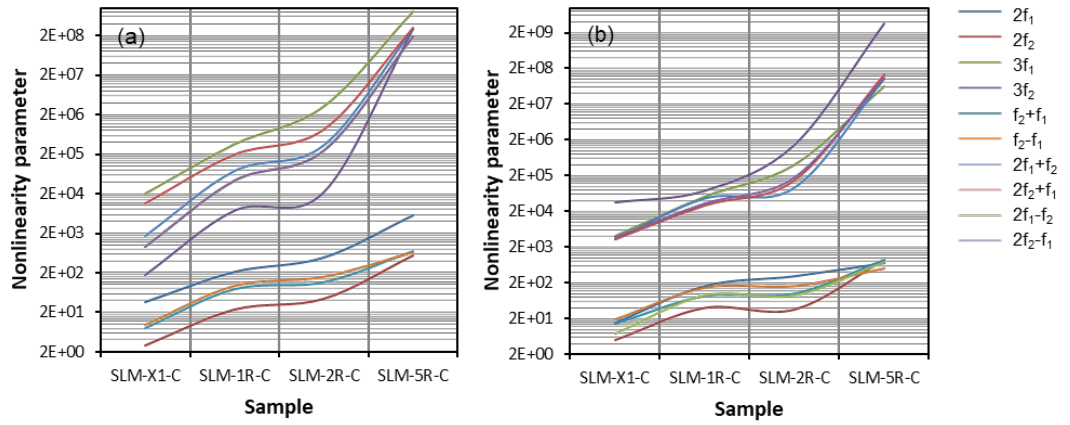
Figure 2. Nonlinearity parameter: ( a ) f 1 = 3 MHz, f 2 = 5 MHz; ( b ) f 1 = 4 MHz, f 2 = 5 MHz. It can be seen that the parameter values measured increase with increasing defect sizes in the samples.